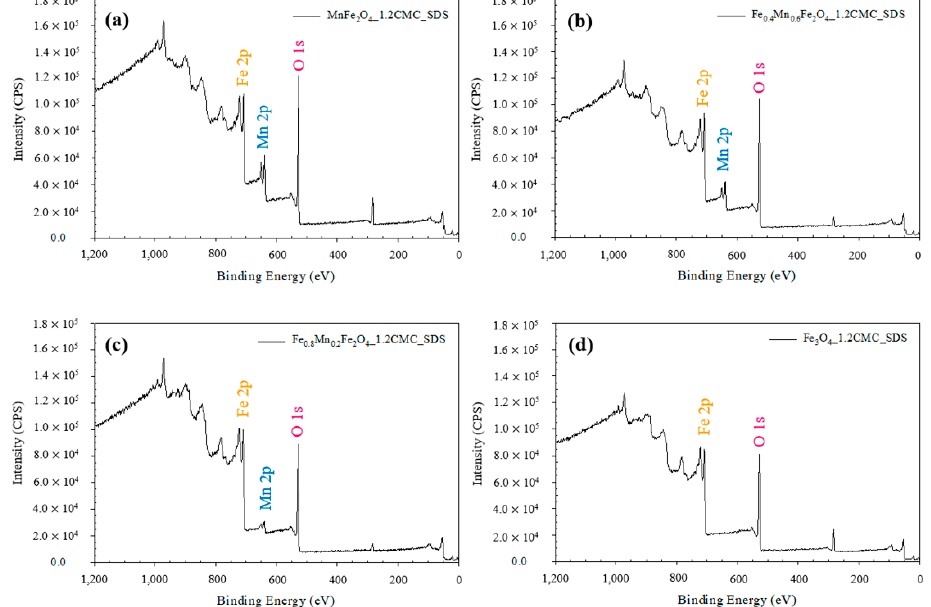
Figure 4. XPS spectra of the synthesized Fe (1-x) Mn x Fe 2 O 4 _1.2CMC_SDS ferrite nanoparticles: ( a ) MnFe 2 O 4 _1.2CMC_SDS, ( b ) Fe 0.4 Mn 0.6 Fe 2 O 4 _1.2CMC_SDS, ( c ) Fe 0.8 Mn 0.2 Fe 2 O 4 _1.2CMC_SDS, and ( d ) Fe 3 O 4